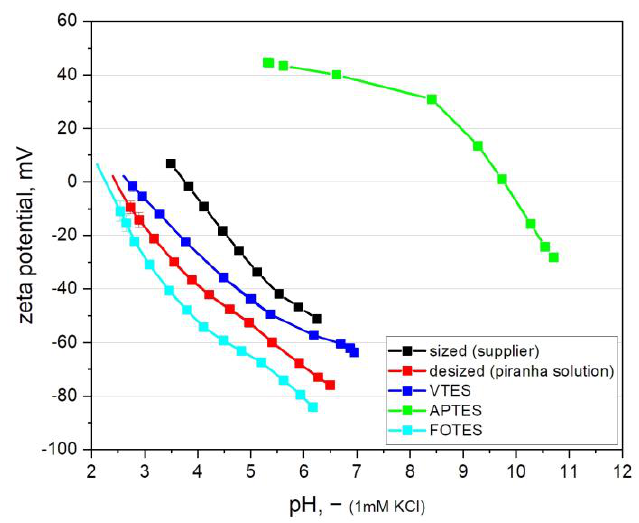
Figure 3. Zeta potential as a function of the pH value of glass fibers prior and after desizing (acidic and basic piranha treatment) and subsequent modification with functional organo-silanes.